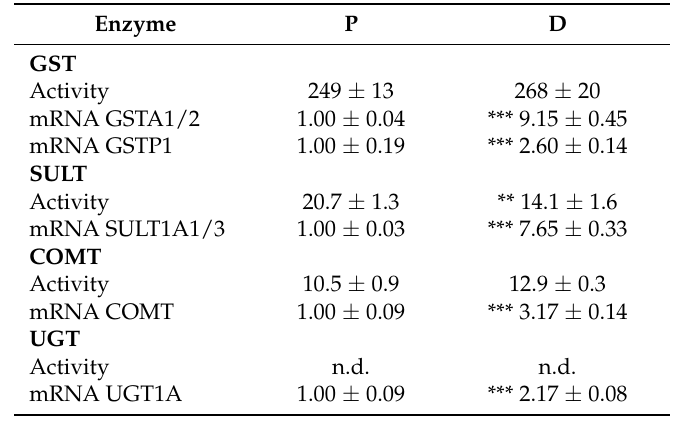
Table 1. Specific activities (nmol/min/mg of protein) and mRNA expression (normalized to GAPDH) of conjugation enzymes in proliferating (P) and differentiated (D) Caco-2 cells.